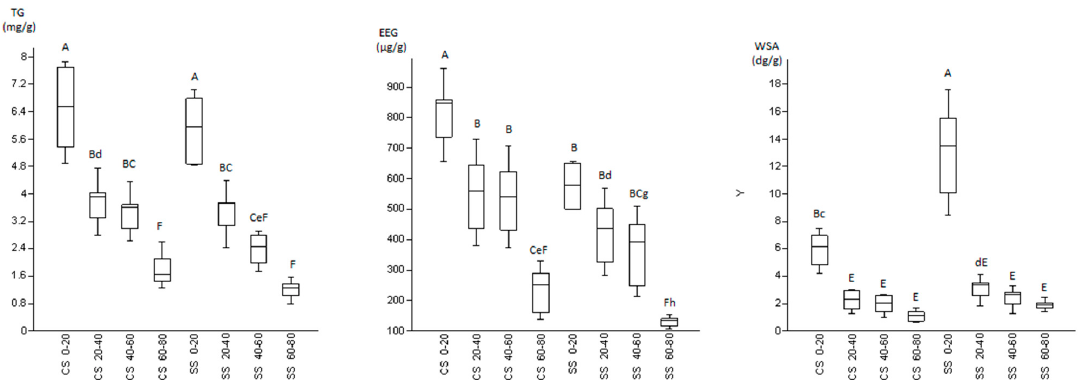
Figure 2. Box plot and Tukey HSD intervals for the pairwise comparisons of total glomalin (TG)/depth, easy extractable glomalin (EEG)/depth and water stable aggregates (WSA)/depth, according to the management system. CS: conventional system; SS: sustainable system. Different capital letters and lowercase indicate a statistical difference at p < 0.01 and p < 0.05 level respectively.